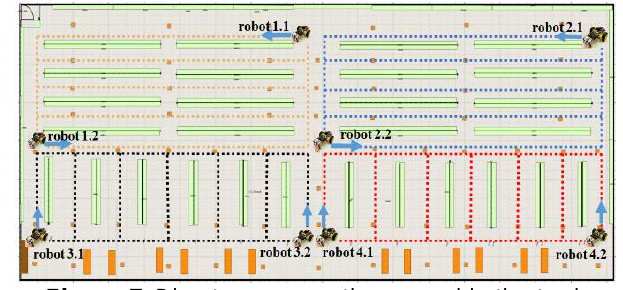
Figure 7 . Plan to move on the ground in the trade centre of the self-acting robots